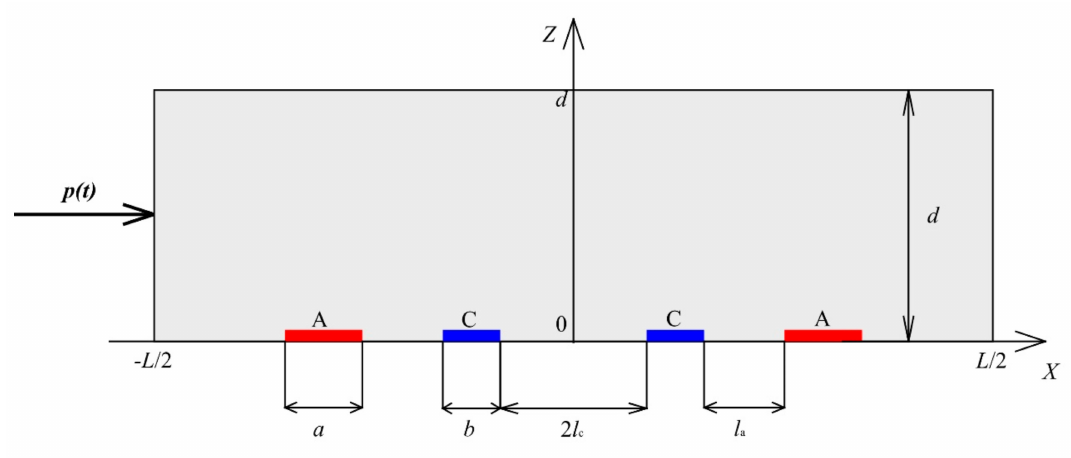
Figure 1. The circuit of the electrochemical cell with flat electrodes (A, anodes; C, cathodes). The channel has length L , thickness d , and width s , s (cid:29) L (cid:29) d . The crosswise size of the electrodes is equal to the channel width, the longitudinal size of the cathodes equals b , for the anodes it equals a , the distance between the cathodes and the anodes of one pair is l a , and the distance between the cathodes is 2 l c . The thickness of the electrodes is small compared to their crosswise and longitudinal dimensions. The X -axis is directed along the channel, the Z -axis is perpendicular to the electrodes plane, and the Y -axis complements the right coordinate system. The origin of coordinates is in the center of the wall on which the electrodes are